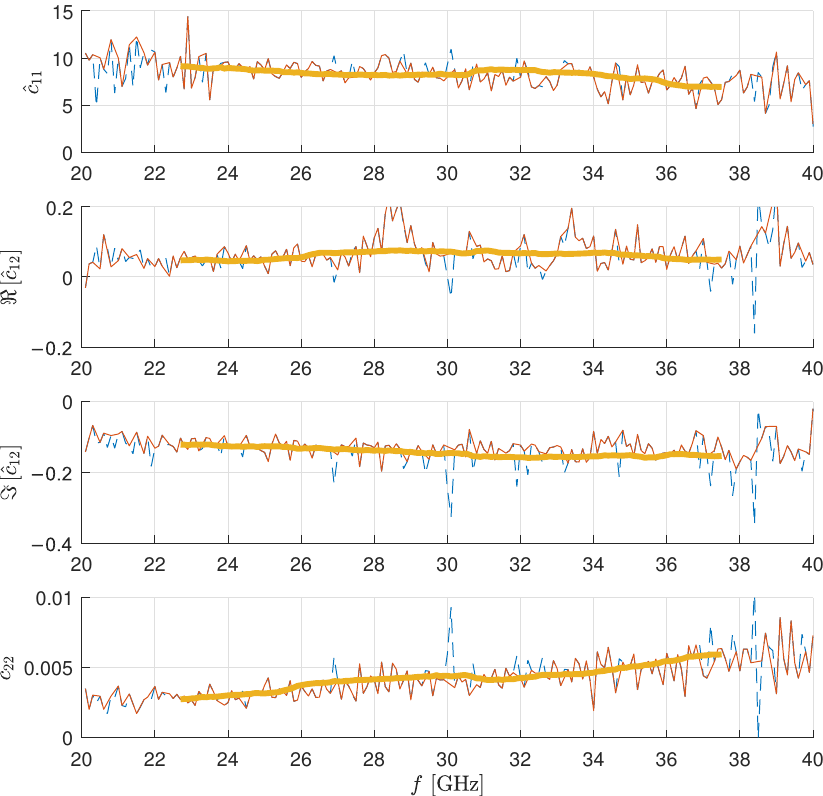
Figure 3. Extraction of the elements of the noise correlation matrix over frequency. Dashed lines: stan- dard extraction ( f 1 = f 0 = f 2 ). Continuous thin lines: physically sound subset of the standard extrac- tion. Continuous thick lines: linearization-based extraction ( f 1 = f 0 − 2.5 GHz, f 2 = f 0 + 2.5